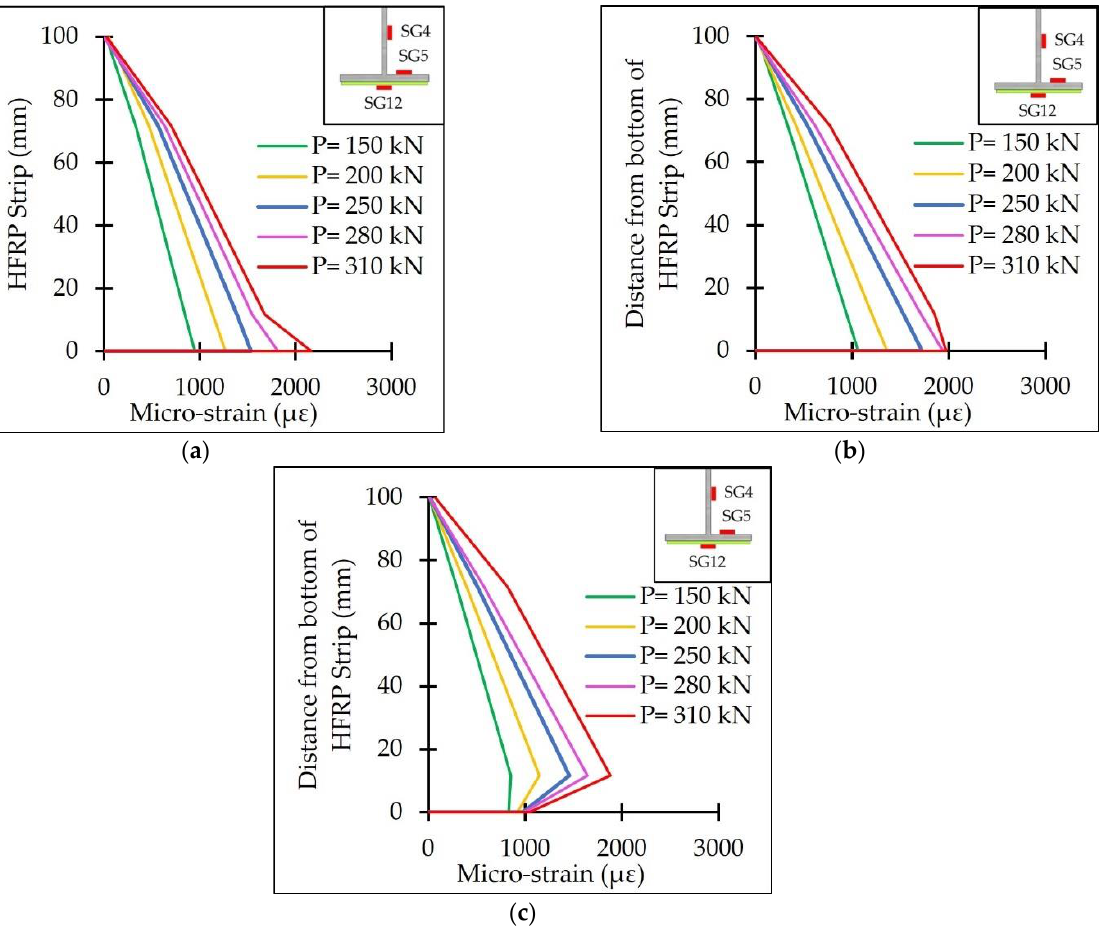
Figure 18. Distribution of the tensile strains of: ( a ) 1620-S-45; ( b ) 1620-S-100; ( c ) 1620-S-150 at the mid-segments.